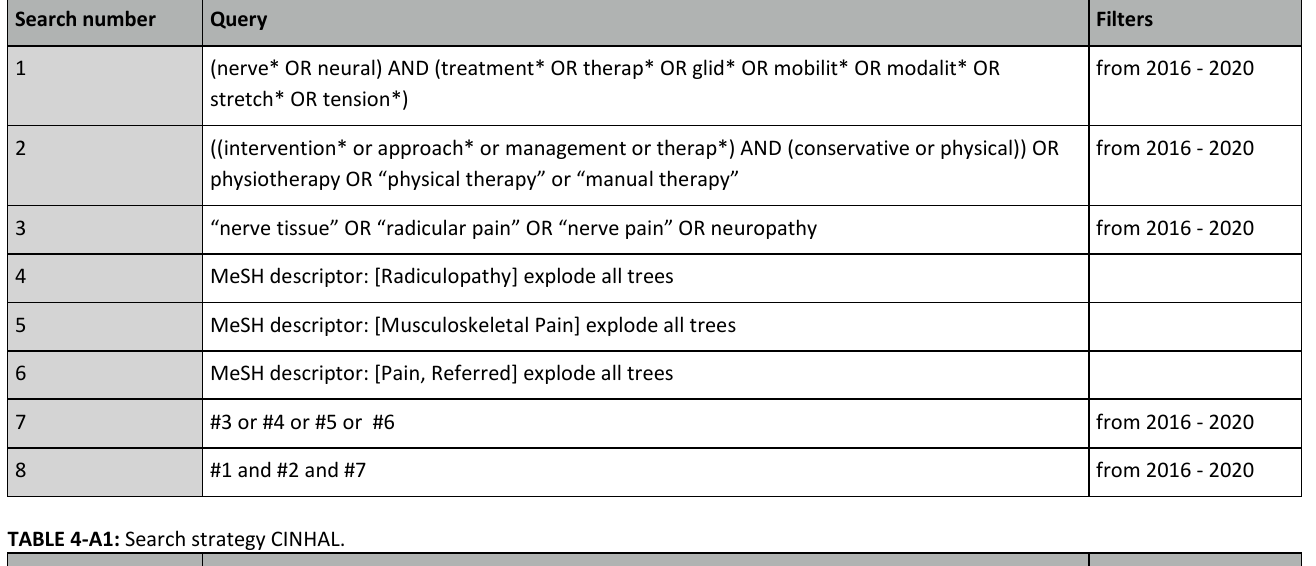
TABLE 4-A1: Search strategy CINHAL.